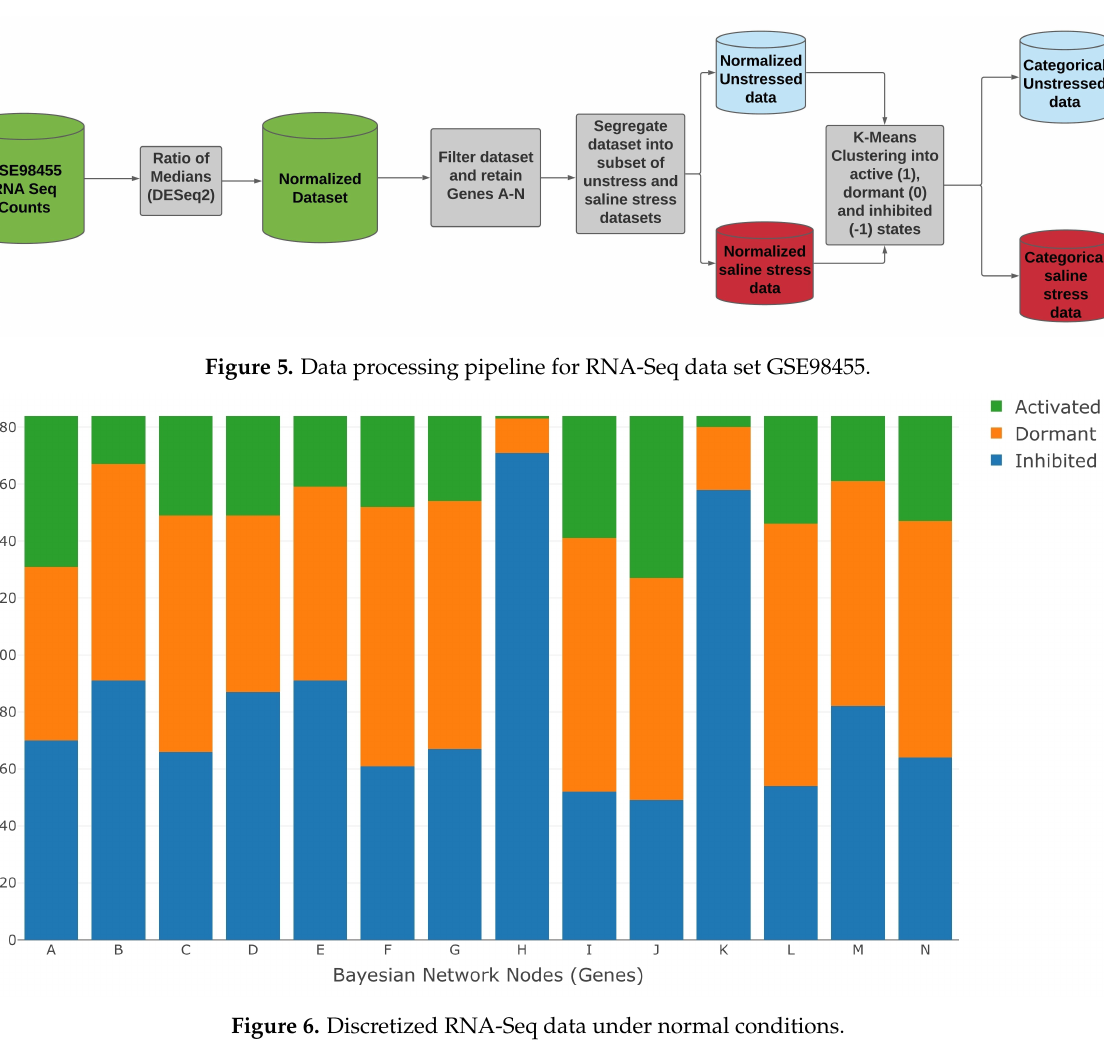
Figure 6. Discretized RNA-Seq data under normal